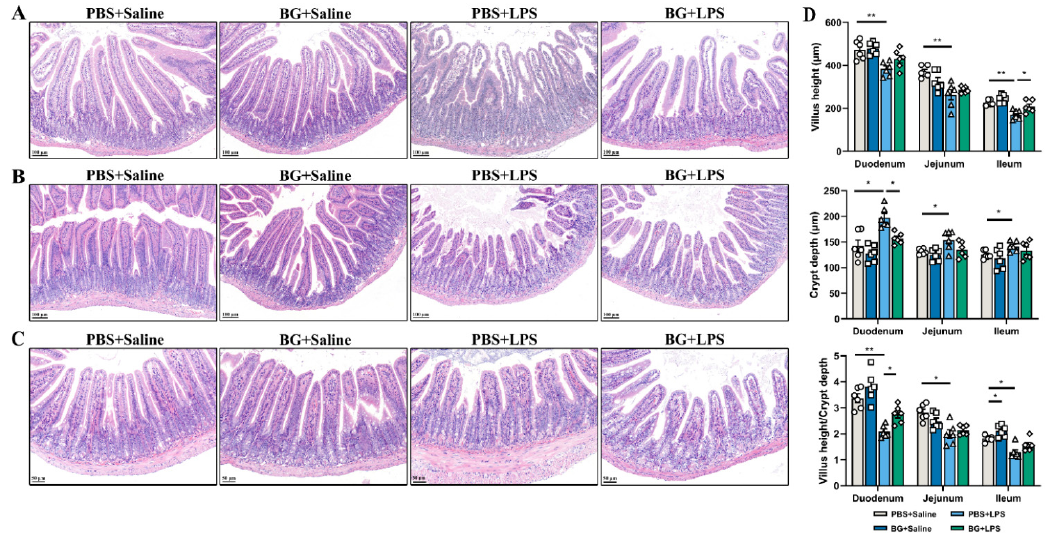
Figure 3. BG maintains intestinal morphology. H&E staining of sections of ( A ) duodenum (scale bar = 100 µ m); ( B ) Jejunum (scale bar = 100 µ m); ( C ) Ileum (scale bar = 50 µ m); ( D ) Villus height, crypt depth, and the ratio of villus height and crypt depth of different sections of the small intestine. PBS+Saline, mice intragastric administered PBS and injection with saline; BG+Saline mice intra- gastric administered 1.5 g/kg BW BG and injection with saline; PBS+LPS, mice intragastrically ad- ministered PBS and injected with LPS; BG+LPS, mice intragastrically administered 1.5 g/kg BW BG and injected with LPS. Data are presented as mean ± SEM, n = 6. * and ** indicate significant differ- ence ( p < 0.05 and p < 0.01, respectively). An unpaired t -test was used for statistical analysis between two groups. 3.3. Ultrastructure of Jejunal and Ileum Epithelial Cells in Mice Induced by LPS Challenging The ultrastructure images of mice jejunal and ileal epithelial cells are shown in Fig- ures 4 and 5. The observed results with TEM (Figures 4A and 5A) showed that BG and PBS ad- ministration exhibited no harm to the jejunal and ileac epithelial cells. The cell gap and the tight junction structures were clear and complete. The microvilli of jejunal and ileac epithelial cells were well arranged. However, LPS stimulation, in the PBS-administered mice, induced the creation of cell gaps in the jejunum and ileal epithelium; the tight junc- tion structures were broken and not clear. The microvilli became shorter and deficient. On the other hand, the BG gavage into the mice, attenuated the ileum brush border and tight junction structures damage caused by the LPS challenging. Nonetheless, there was no ob- vious relief effect on jejunum epithelial cells. As shown in Figures 4B and 5B, LPS stimulation decreased microvilli length and mi- crovilli root density in the jejunum and ileum epithelial cells ( p < 0.05). BG administration attenuated LPS-induced length shortening in the ileum epithelial cells ( p < 0.05) but did not attenuate the reduction in microvilli root density in the jejunum and ileum ( p > 0.05). The observed results with SEM showed that the microvilli were intact, arranged and compact in the PBS and the BG groups injected with saline (Figures 4C and 5C). LPS stim- ulation decreased the microvilli density of the jejunum and ileal epithelial cells in both PBS and BG in LPS stimulation. However, BG administration attenuated the microvilli loss.